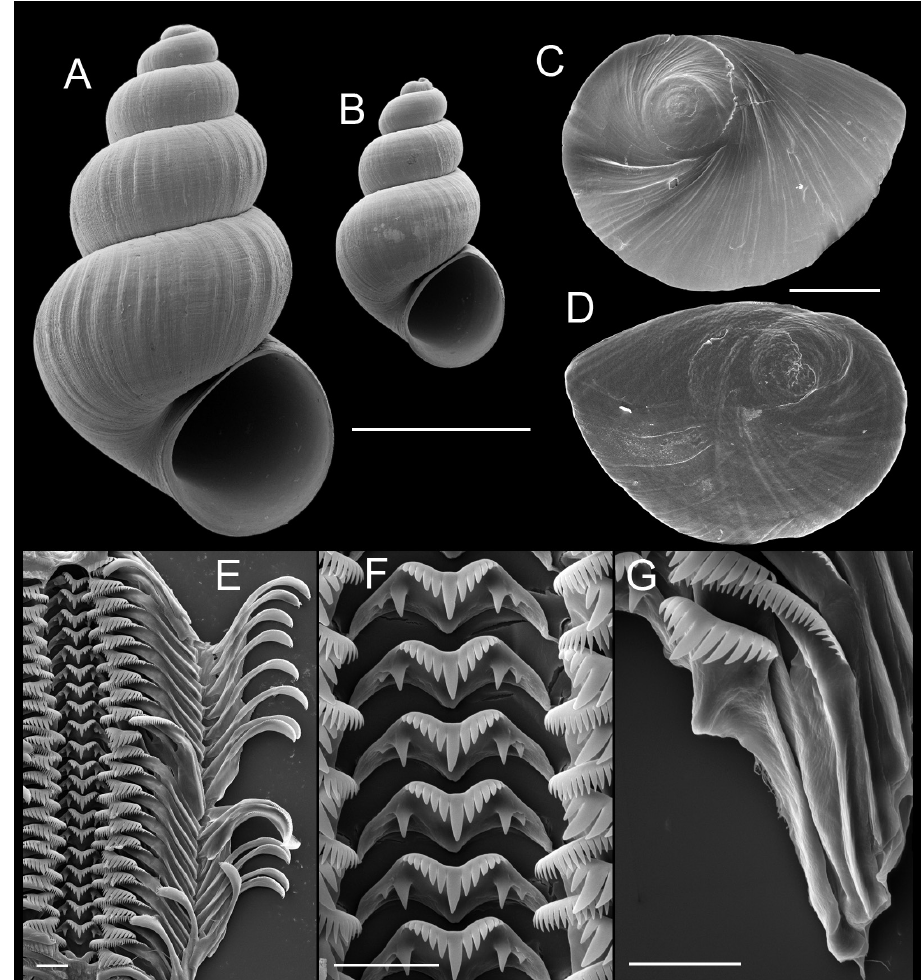
Figure 4. Shells, opercula and radula, T. infernalis sp. n. A Holotype, USNM 883884 B Male shell, USNM 1266143 C, D Opercula (outer, inner sides), USNM 1266143 E Portion of radular ribbon, USNM 1266143 F Central teeth, USNM 1266143 G Lateral and inner marginal teeth, USNM 1266143. Scale bars A–B : 1.0 mm; C, D : 200 µm; E–G : 10